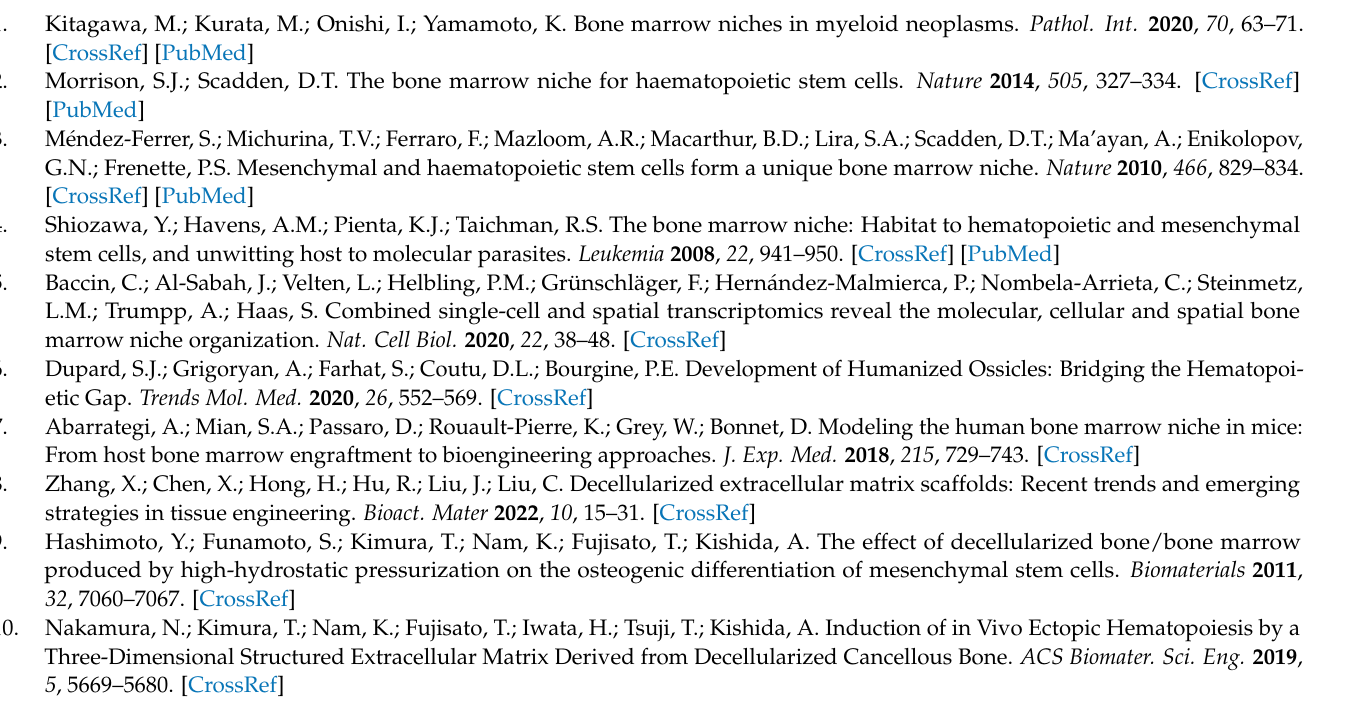
Table S2: Profile of the running ES Score and positions of geneset members on the rank ordered list